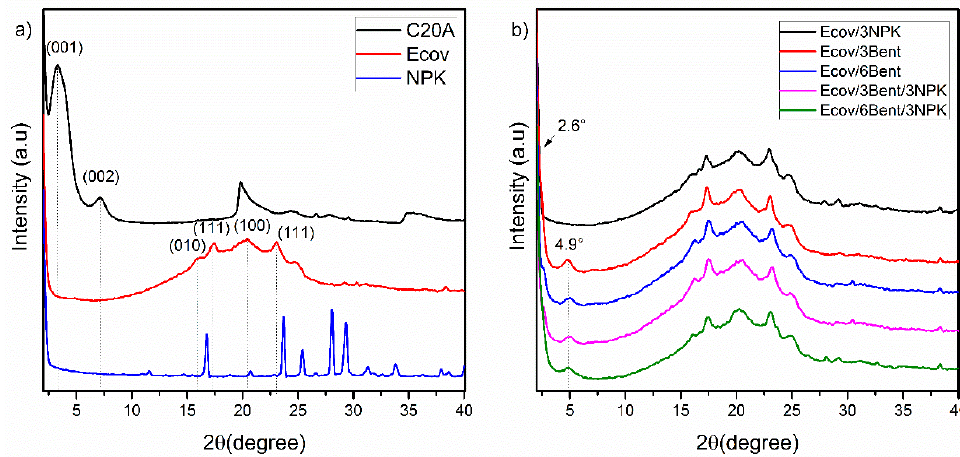
Figure 3. XRD of: ( a ) Cloisite 20A ® (C20A), NPK and neat Ecovio ® (Ecov); ( b ) XRD of: Ecov/3NPK, Ecov/3Bent, Ecov/6Bent, Ecov/3Bent/3NPK and